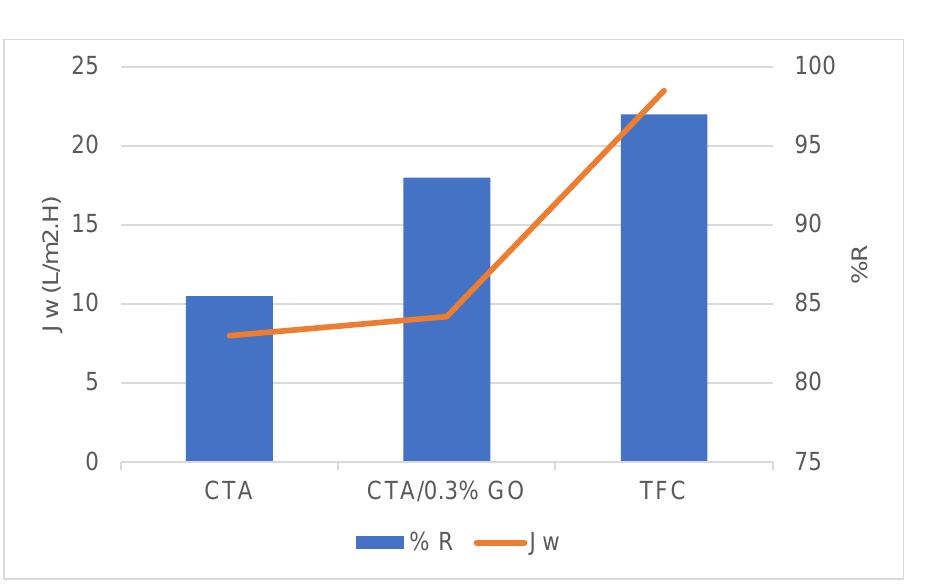
Figure 13. Water flux and salt rejection using a natural seawater sample collected from Hurgada – Red Sea coast of Egypt and NaCl as the draw solution (DS) at 25 °C, flowrate1.55 L/min, FO mode: with cells vertically oriented, and active layer — faced feed solution (AL-FS), using Neat CTA, CTA/0.3%GO, and TFC modified membranes. Table 5. Physico-chemical analysis of seawater. Table 4. Comparison between FO prepared membranes in the present work and previously reported FO